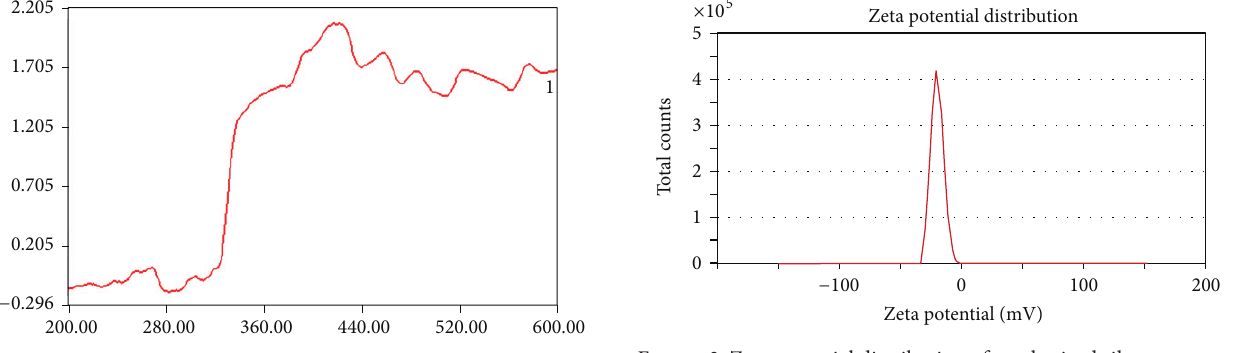
Figure 1: UV-visible absorption spectra of synthesized silver nano- particles.